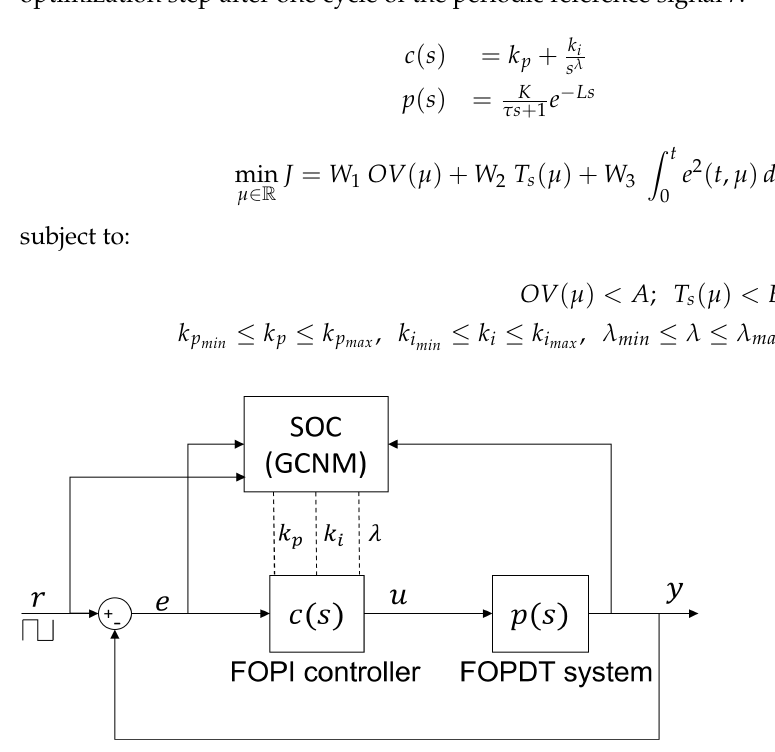
Figure 1. Proposed self optimizing control architecture with FOPI